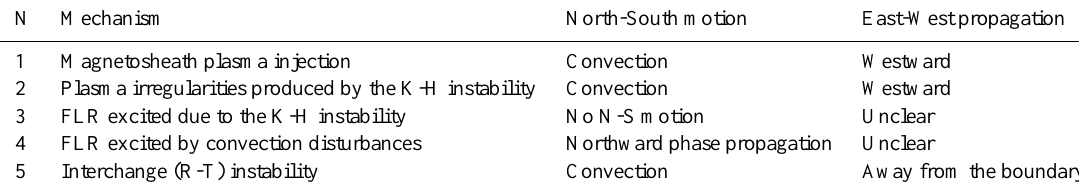
Table 1. Possible mechanisms for the pre-noon auroral arcs